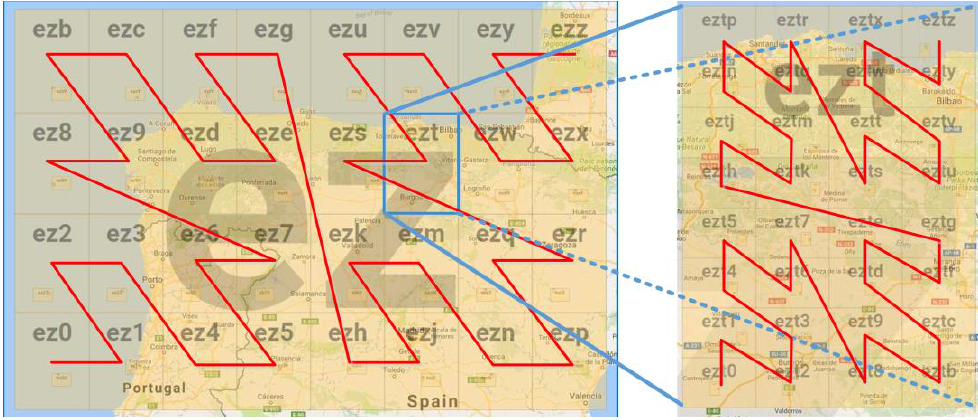
Figure 3. Z-order Filling Curve to Show Geohash Division. Maps are generated by using the Geohash Explorer service [31].